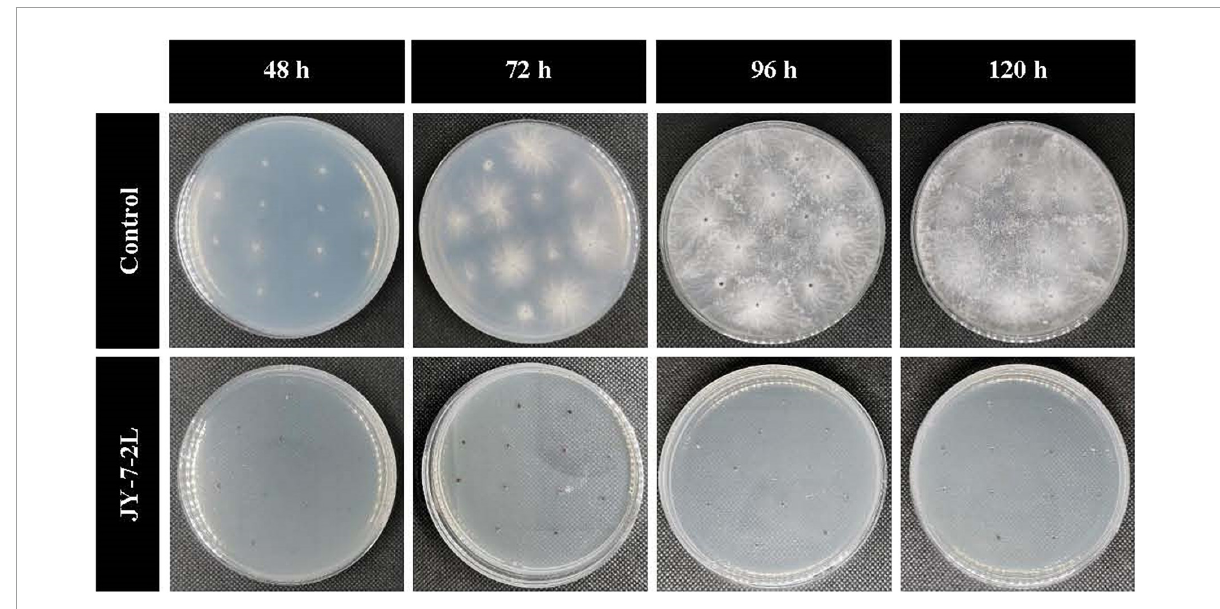
FIGURE4 Effect of cell-free culture filtrate of JY-7-2L on sclerotia germination of Sclerotium rolfsii